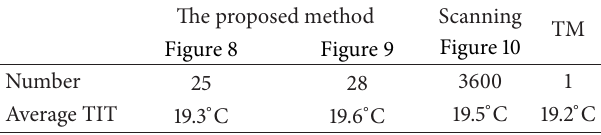
Table 1: The number and average TITs of the obtained